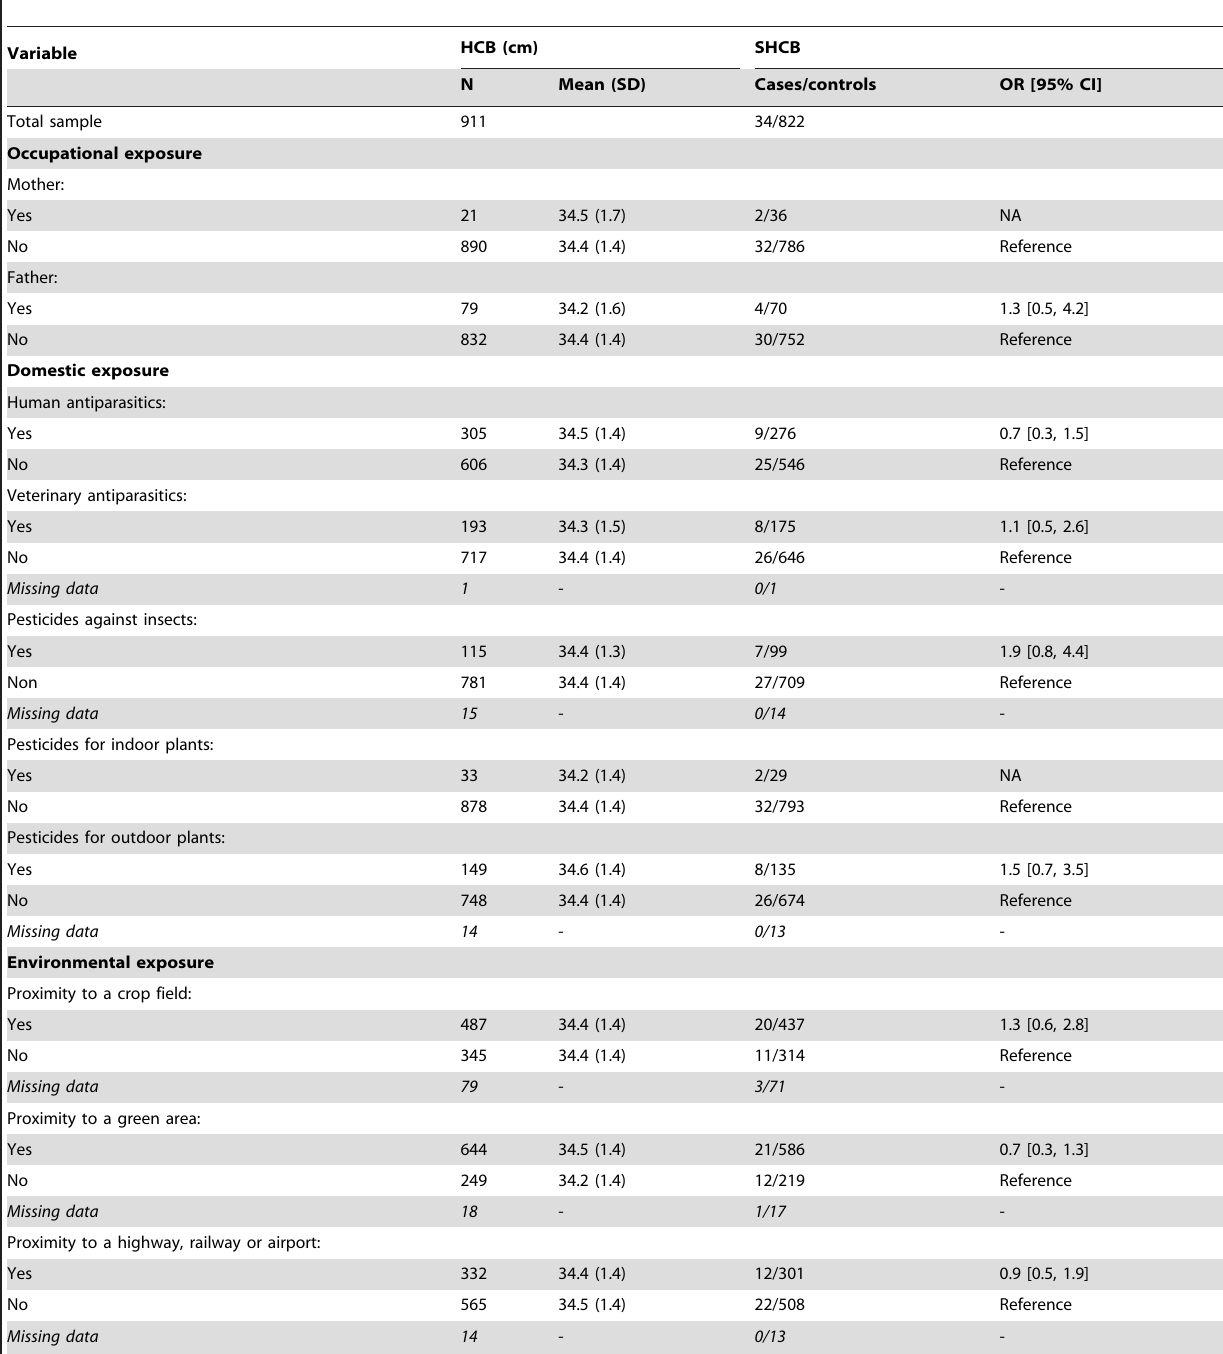
Table 11. Multivariate associations between (i) variables related to in utero exposure to pesticides, (ii) head circumference at birth (HCB, in cm) and (iii) small head circumference at